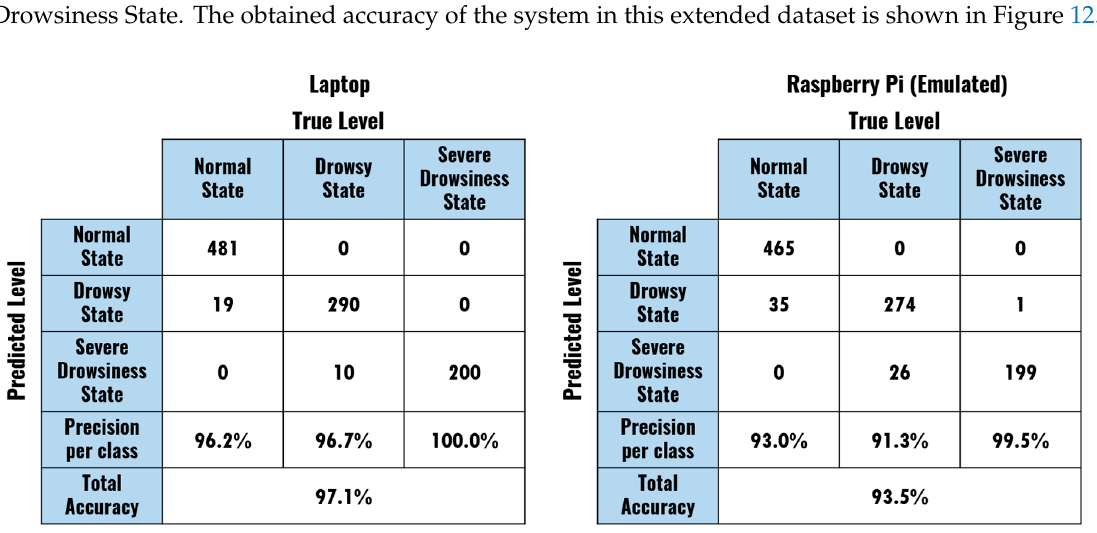
Figure 12. Confusion matrices describing the performance of the model for a more significant number of subjects.